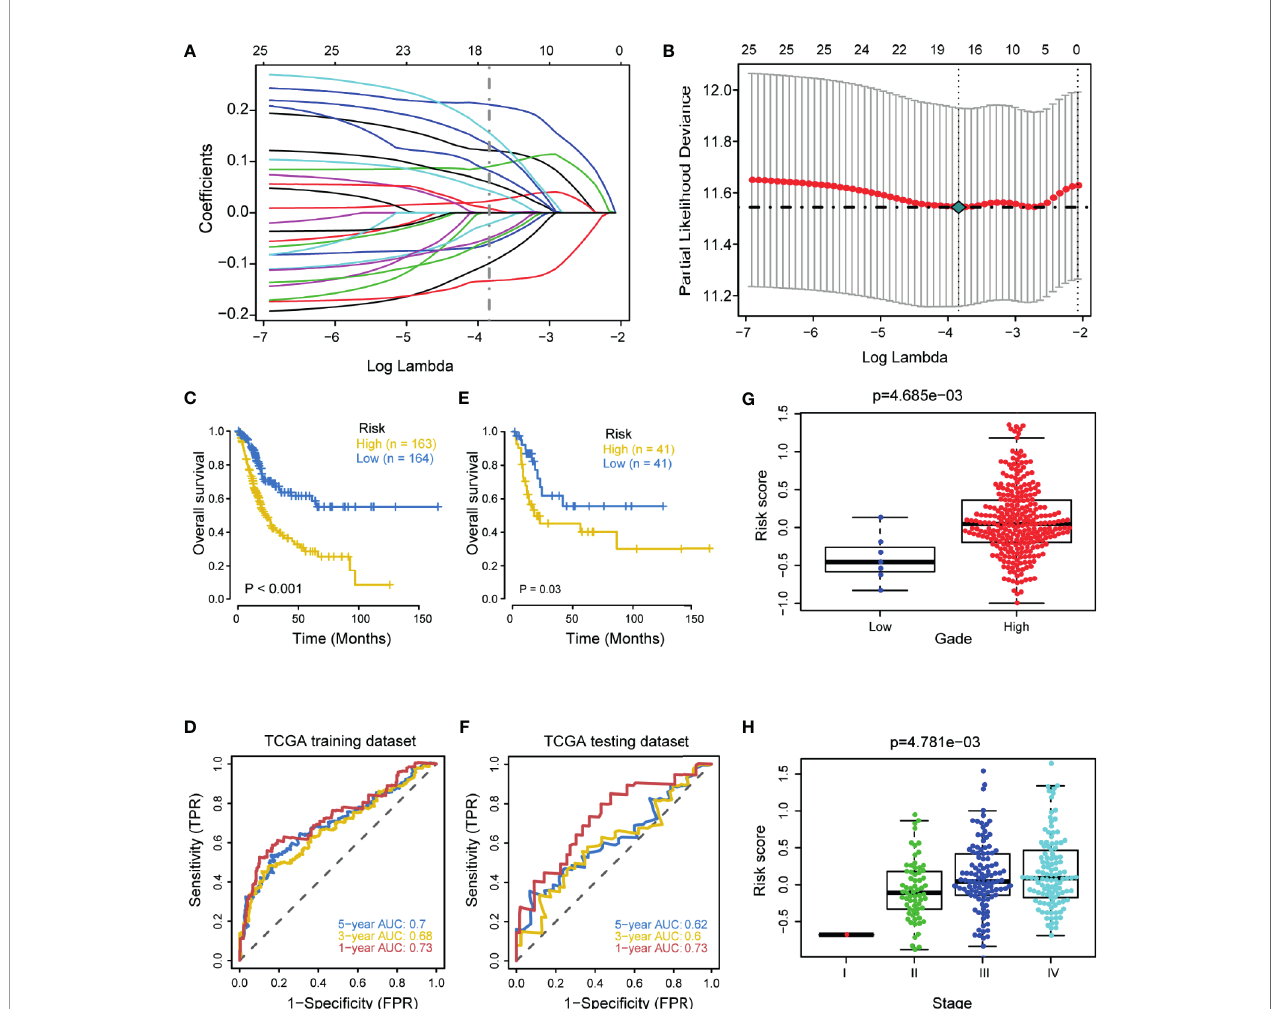
FIGURE 1 | Development and internal validation of a hypoxia risk score in the TCGA-BLCA cohort. (A) LASSO coef fi cient pro fi les of 25 prognostic hypoxia genes in TCGA training cohort. The coef fi cient pro fi le plot was developed against the log (Lambda) sequence. (B) Cross-validation for turning parameter selection via minimum criteria in the LASSO regression model. Two dotted vertical lines were plotted at the optimal values using the minimum criteria. Optimal RNAs with the best discriminative capability (16 in number) were selected for developing the hypoxia risk score. (C, D) Development of the hypoxia risk score in TCGA training set and the predictive accuracy of the hypoxia risk score for survival. (E, F) Validation of the hypoxia risk score in TCGA validation set. (G, H) Associations between the hypoxia risk score and tumor grade and